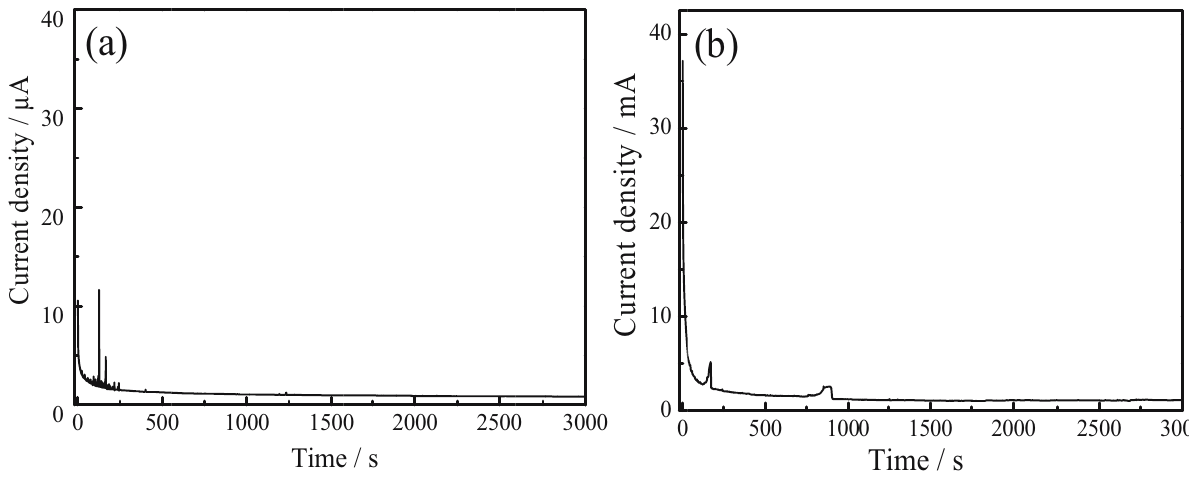
Figure 7: Potentiostatic polarization curves of experimental steel samples in 10% NaCl at 25°C. ( a ) FSS1 and ( b )